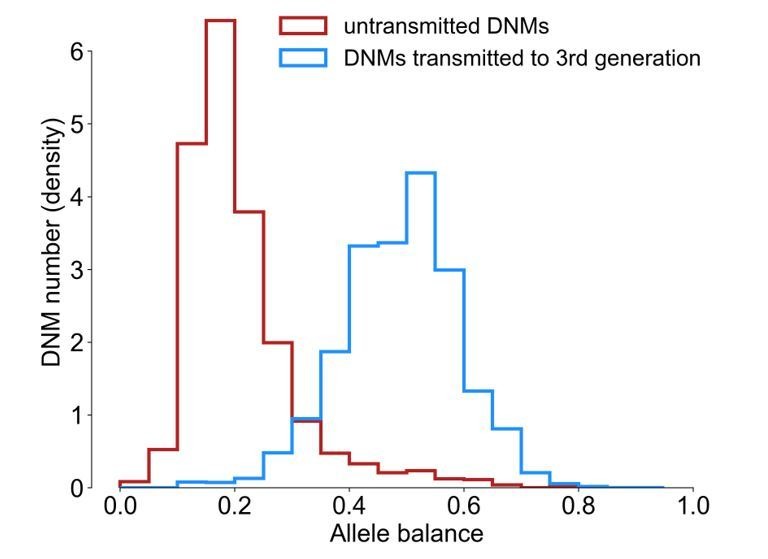
Allele balance distributions in transmitted and untransmitted DNMs.Allele balance was calculated as the fraction of reads supporting the alternate (i.e., de novo) allele at a particular site. As there are substantially more transmitted than untransmitted DNMs in the plot, the y-axis is shown as the normalized count of DNMs.